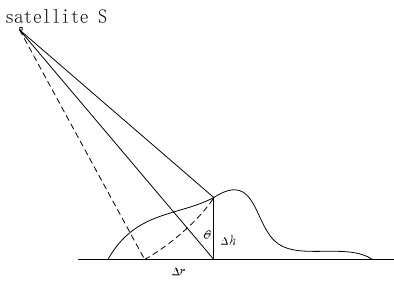
Figure 1. Positioning error caused by topographic relief.